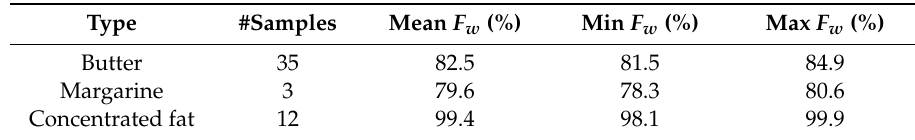
Table 1. Dataset summary. F w is the % w / w of fat.